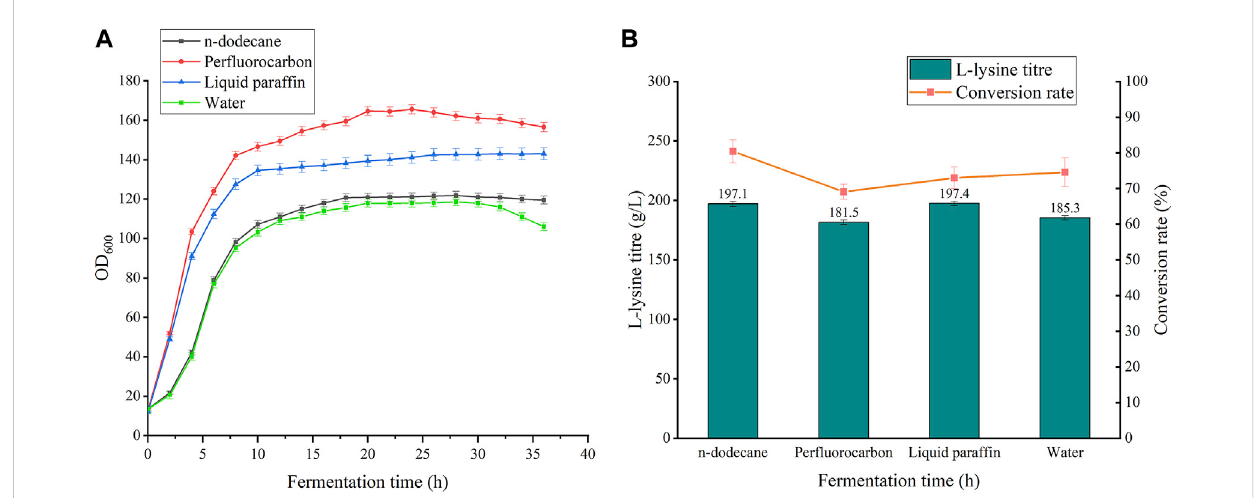
FIGURE 6 Effects of different oxygen vectors on the fermentation process of strain LS260. (A) Cell growth curves of different oxygen vectors. (B) Lysine titers and glucose-lysine conversion of different oxygen vectors.